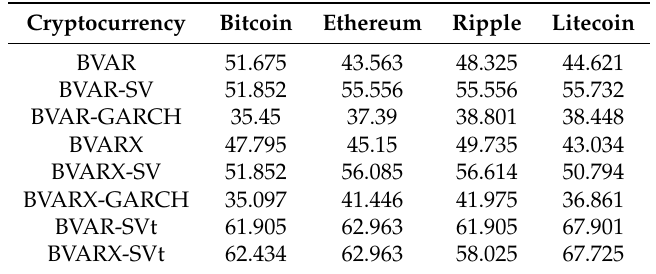
Table 3. Percentage of forecasts in the right direction (up or